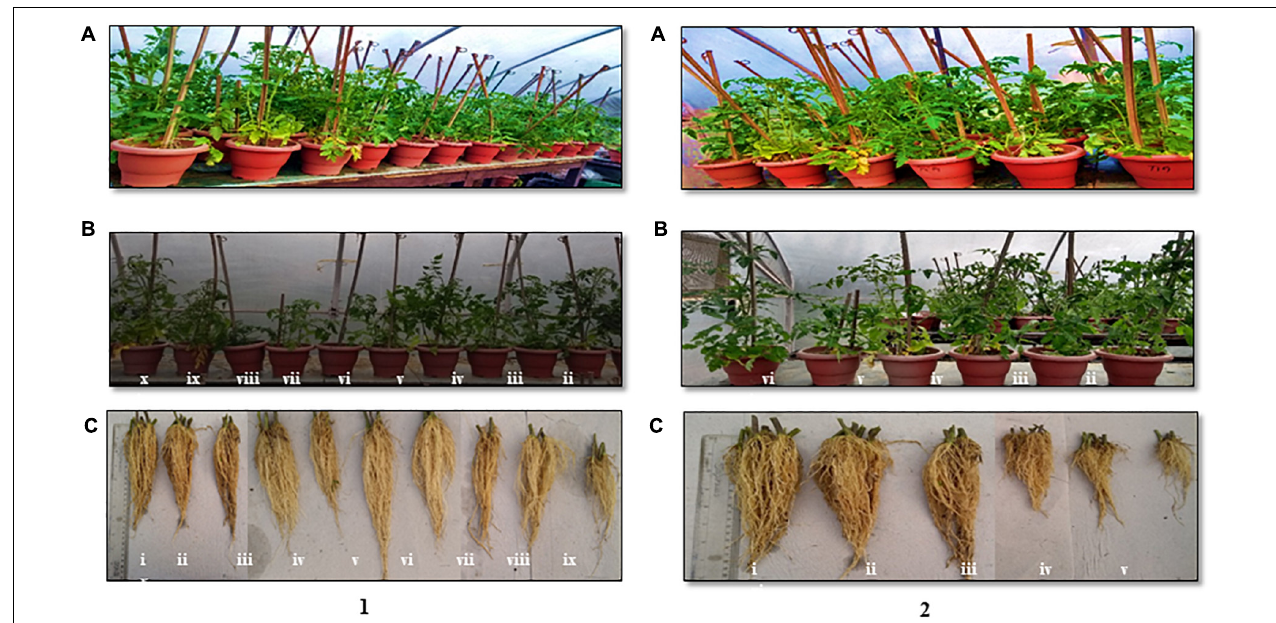
FIGURE 6 | Polyhouse evaluation of the biocontrol agents to manage Fusarium wilt of tomato on challenge inoculated with the highly virulent Fusarium oxysporum strain, TOFU-IHBT (A) overview (B) shoot length (C) root length. (1) pot experiments with cell suspensions (i) S2BC-1 + TEPF-Sungal-1 + S17TH; (ii) S2BC-1 + S17TH + CG-A; (iii) TEPF-Sungal-1 + CG-A + S17TH; (iv) S2BC-1; (v) TEPF-Sungal-1; (vi) S17TH; (vii) CG-A; (viii) pathogenic (TOFU-IHBT) control; (ix) fungicide (copper oxychloride-0.25%-rcarbendazim-0.1%) control; (x) untreated control. (2) pot experiments with carrier based bioformulations (i)